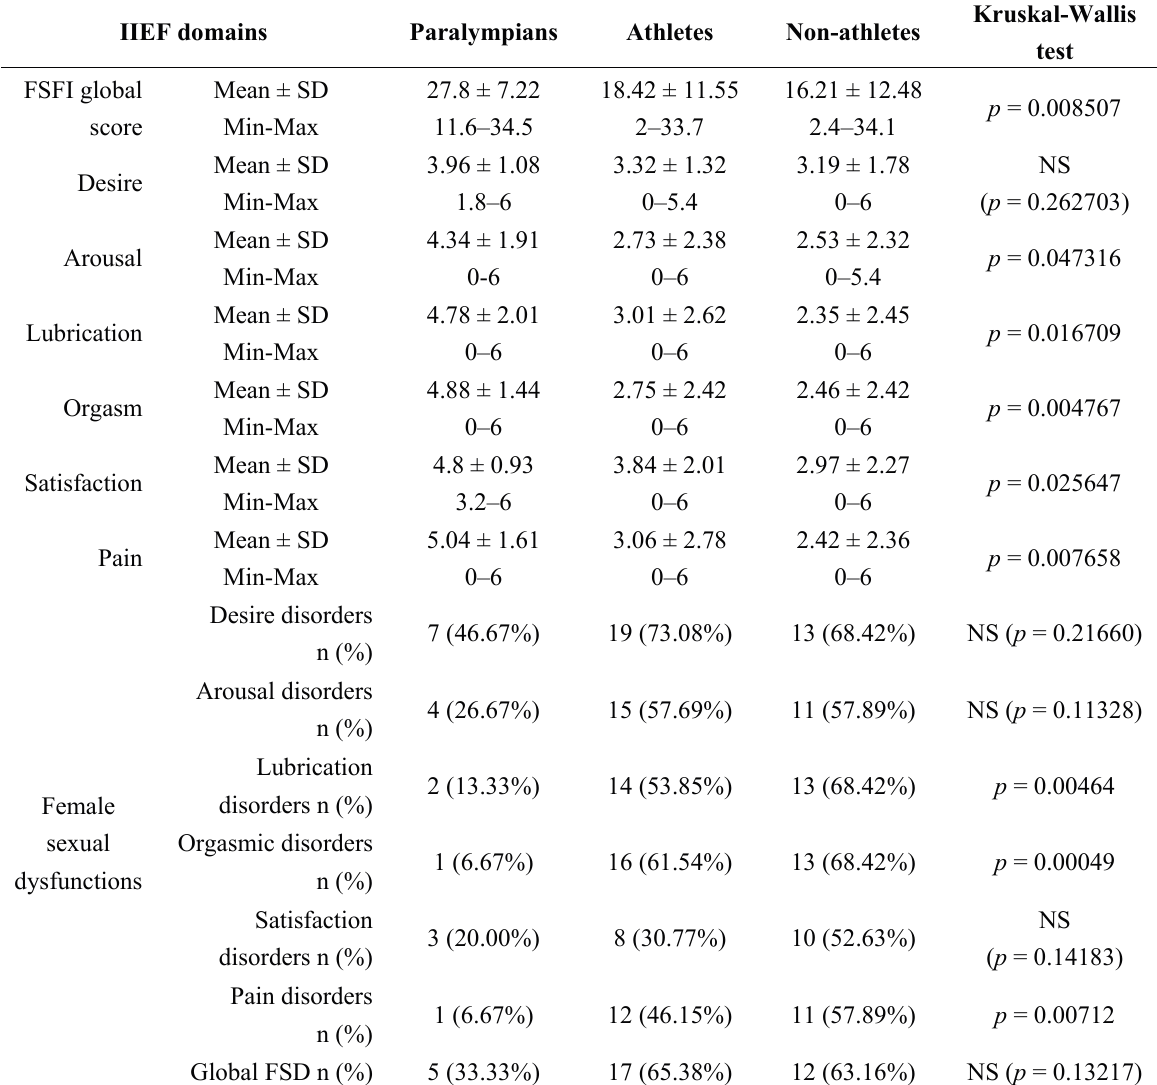
Table 4. FSFI scores and sexual dysfunctions in studied women (mean ± SD; min–max;